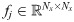
Radon Transform of an omnidirectional image.(a) sample omnidirectional image fj∈RNx×Nx, (b) Radon Transform of the sample image and (c) final RT descriptor of the sample image rj∈R360×0.5Nx.